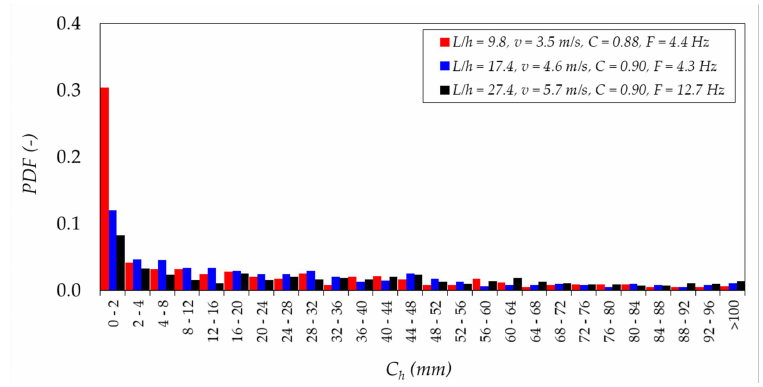
Figure 14. Probability density function of air bubble chord lengths in rectangular